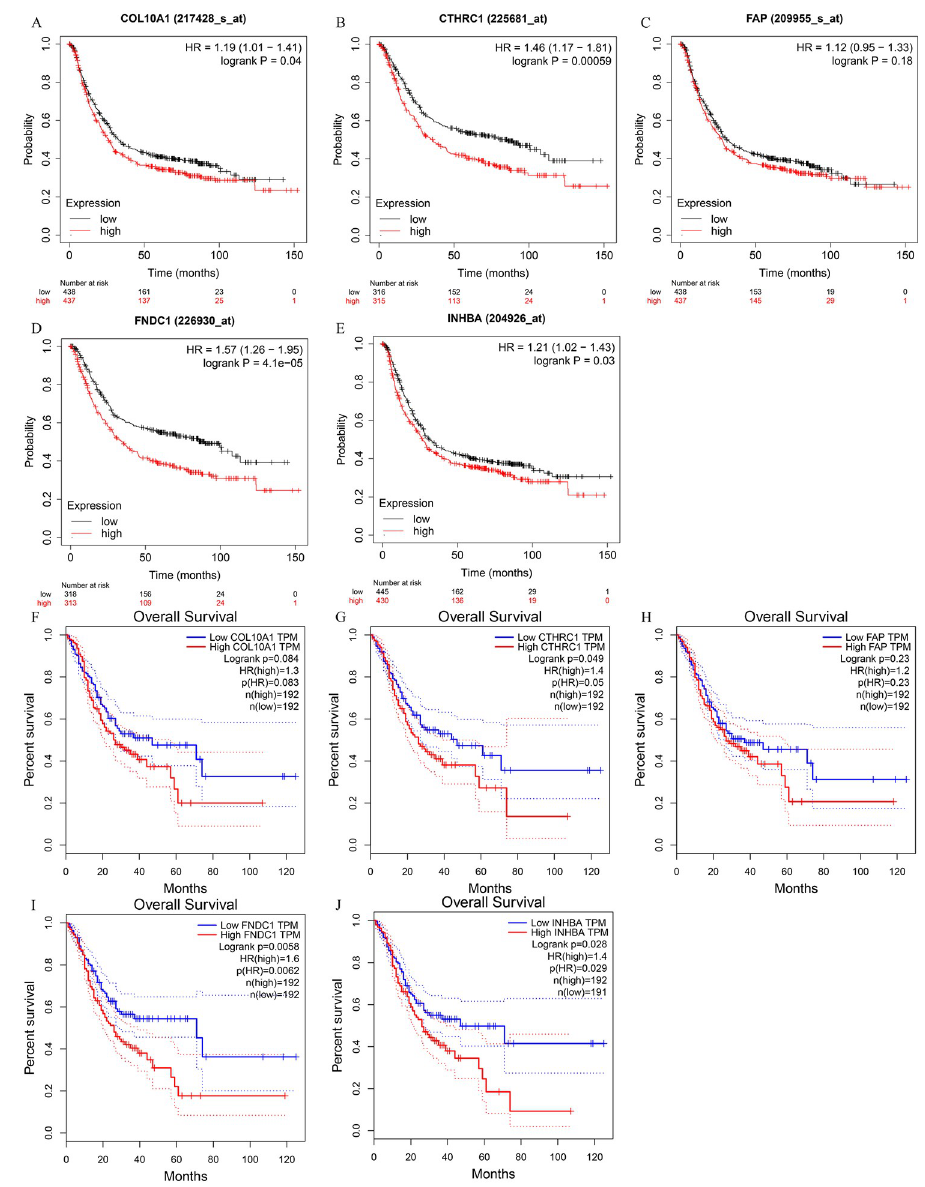
Fig 5. The Kaplan–Meier survival curves of the 5